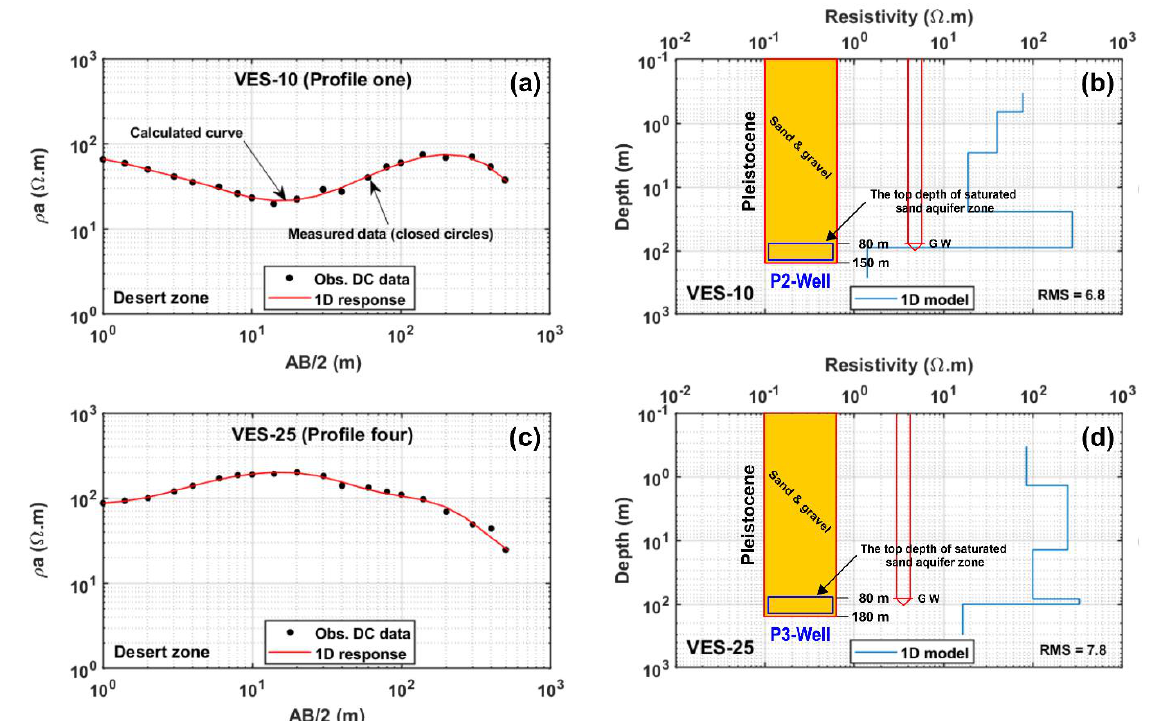
Figure 6. ( a , c ) Observed and calculated apparent resistivities as a function of electrode distances (AB/2) for the VES-10 and VES-25, ( b , d ) 1D inversion models of the observed apparent resistivities of the VES-10 and VES-25, and its comparison with the nearest boreholes (P2 and P3 Wells, respectively, Figure 1c,d).